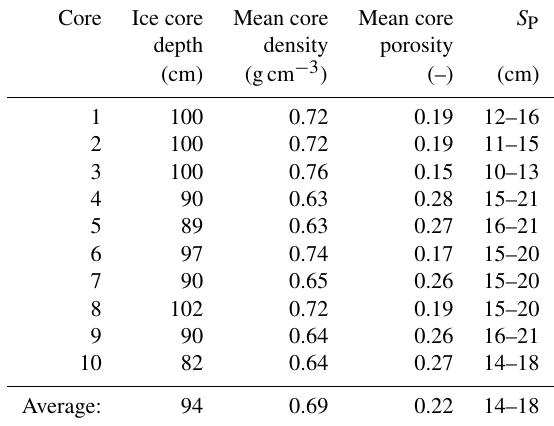
Table 1. Shallow ice core depth, mean core density, mean core porosity, and specific water storage depth ( S P ) , for each shallow ice